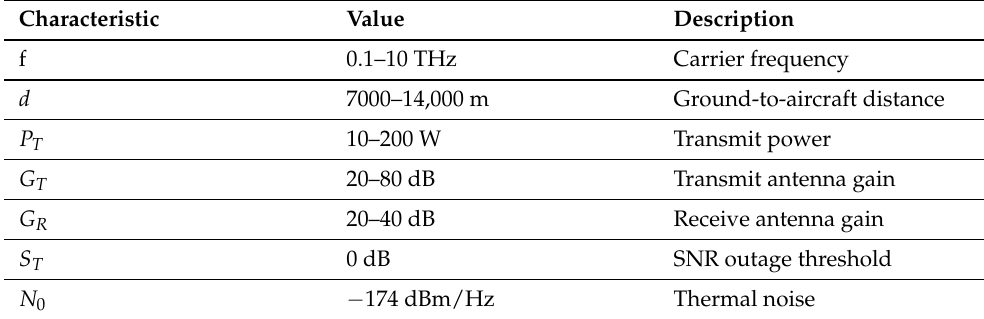
Table 4. The default system